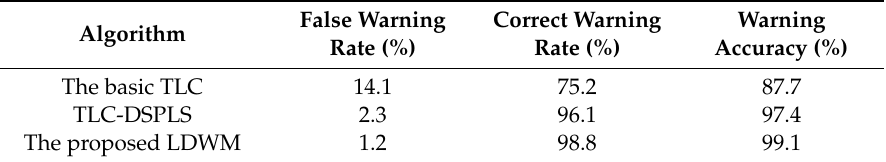
Figure 12. Comparison of False Warning Rate and Correct Warning Rate. Table 4. Comparison of Warning Performance.